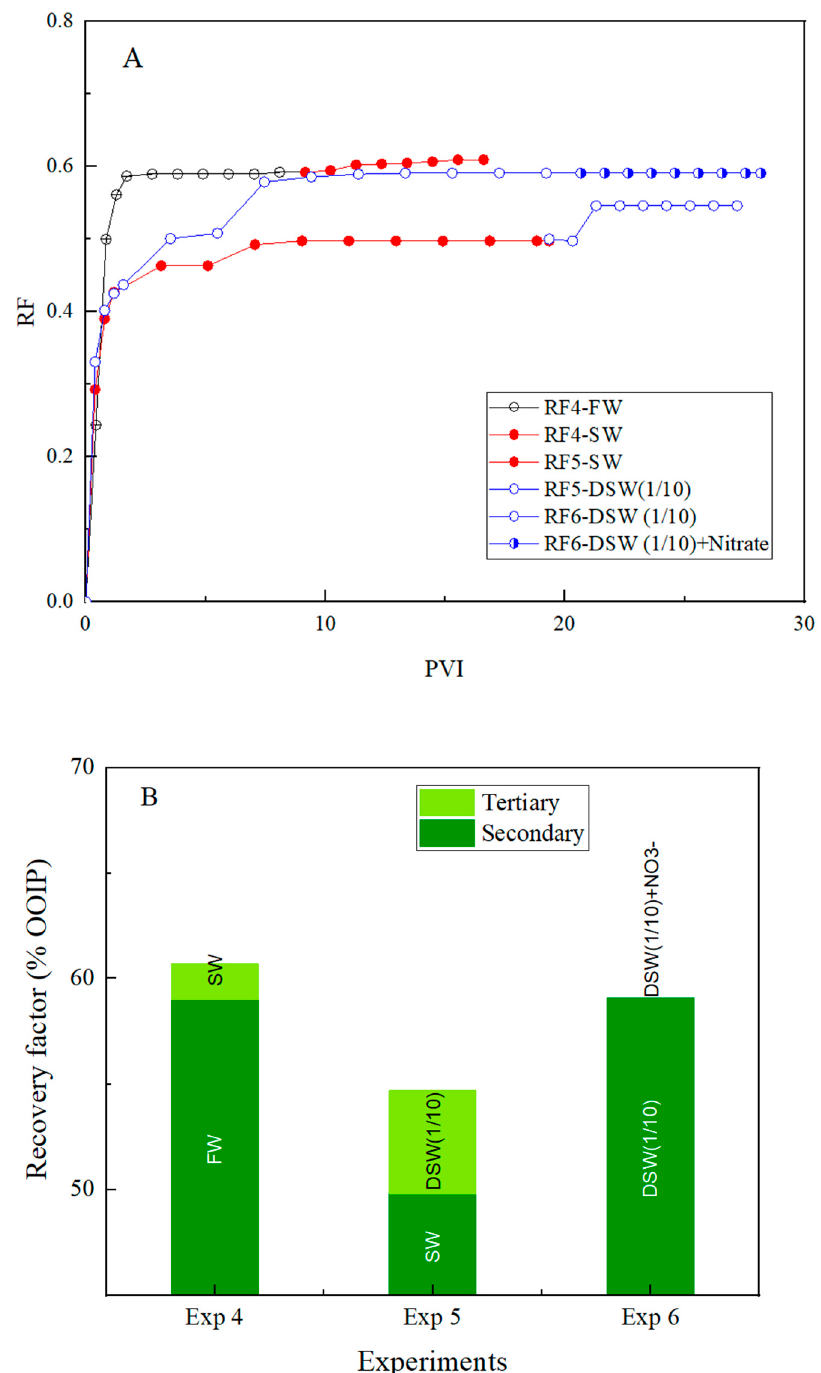
Figure 7. ( A ) Recovery factors for secondary and tertiary stages of flooding for experiments 4 to 6 on samples from Ekofisk formation. ( B ) Comparison of recovery factors as percentage of initial oil in place. Recovery factor curves versus injection pore volumes for all the flooding stages (after tertiary) are shown in supplementary file (Figure S1).